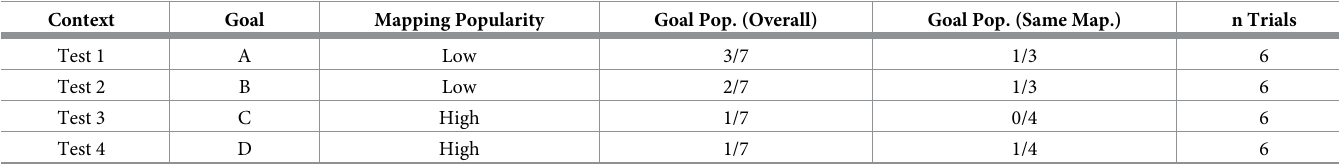
Table 2. Test contexts for experiment 2. Goal popularity, both overall and for contexts with shared mappings, is denoted as the fraction of contexts in training with the same